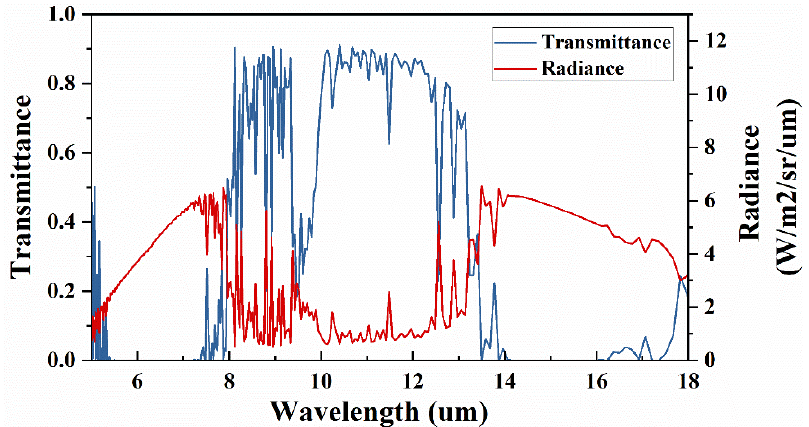
Figure 3. Clear-sky downwelling spectrum radiance (red line) and atmospheric transmittance (blue line) versus wavelength, simulated using MODTRAN for the zenith path to space through a 1976 US Standard Atmospheric model.